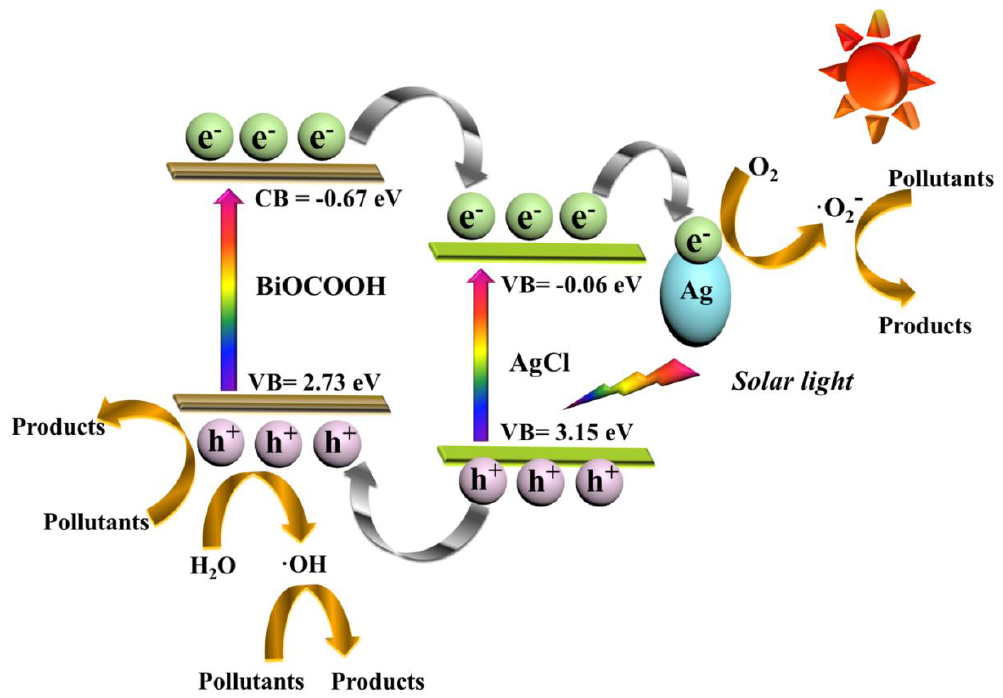
Figure 10. Photocatalytic mechanism of the ternary Ag/AgCl/BiOCOOH heterojunction photocatalyst under simulated sunlight.